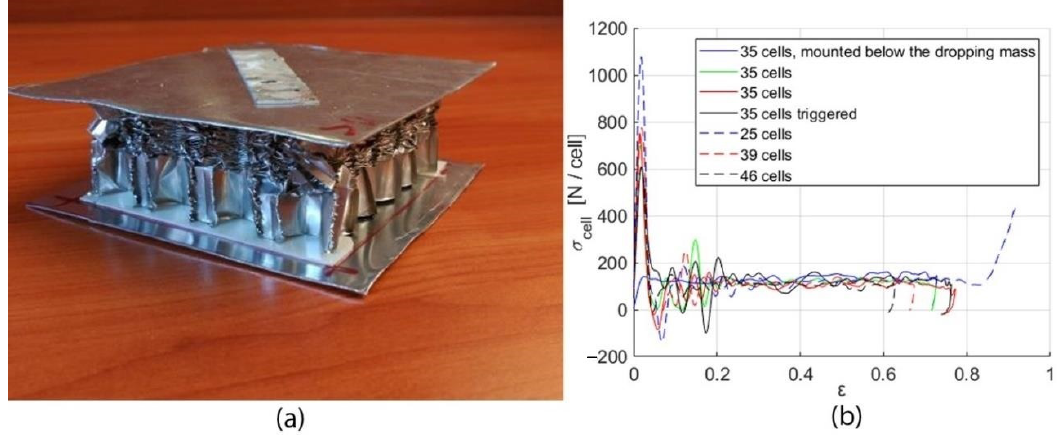
Figure 8. Honeycomb characterization tests: ( a ) honeycomb block after test; ( b ) normalized load– displacement.